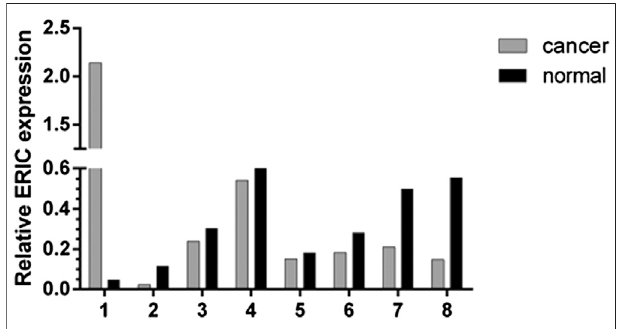
FIGURE 3 | Expression of ERIC gene in bladder cancer tissues and paracancer tissues of 8 patients. The relative expression level of ERIC was determined by qRT-PCR assay. The mean value was shown.